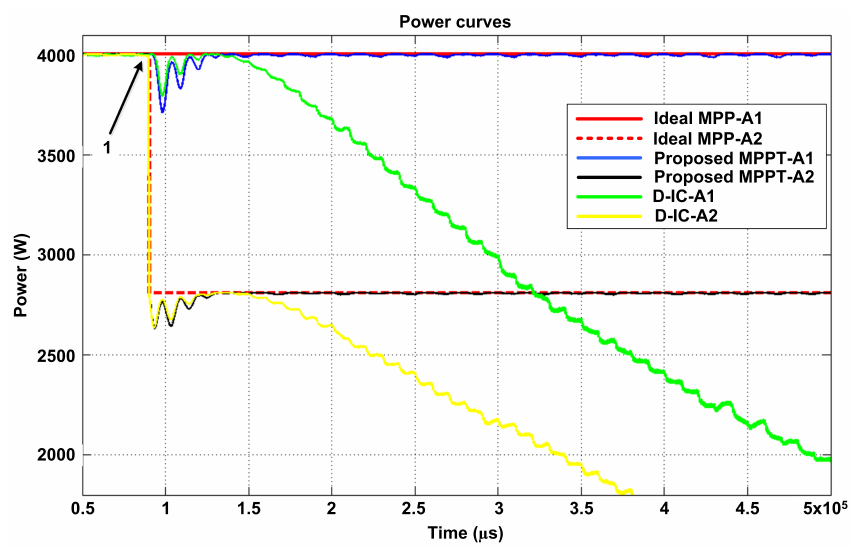
Figure 16. Partial Shading Case 2: Response of